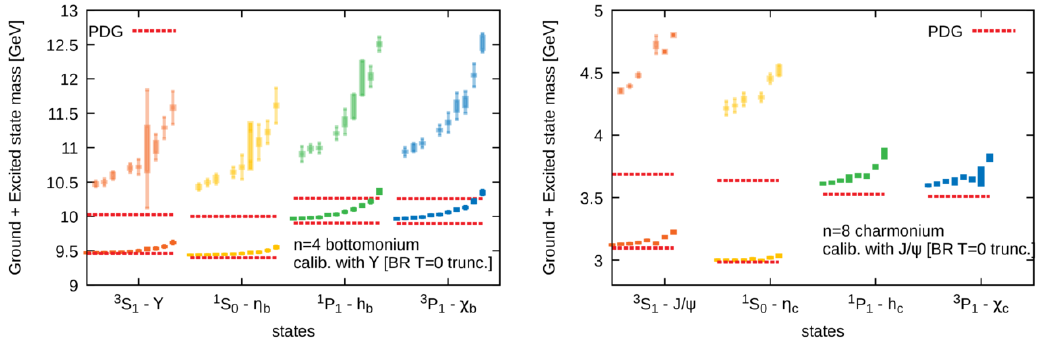
Figure 15 . Representative examples of the extracted values for the ground and (cid:12)rst excited states masses from the BR method based on truncated input. The systematic shift of the obtained value is manifest in every channel, a stark reminder that such an e(cid:11)ect needs to be taken into account when interpreting the results of a genuine (cid:12)nite temperature spectral